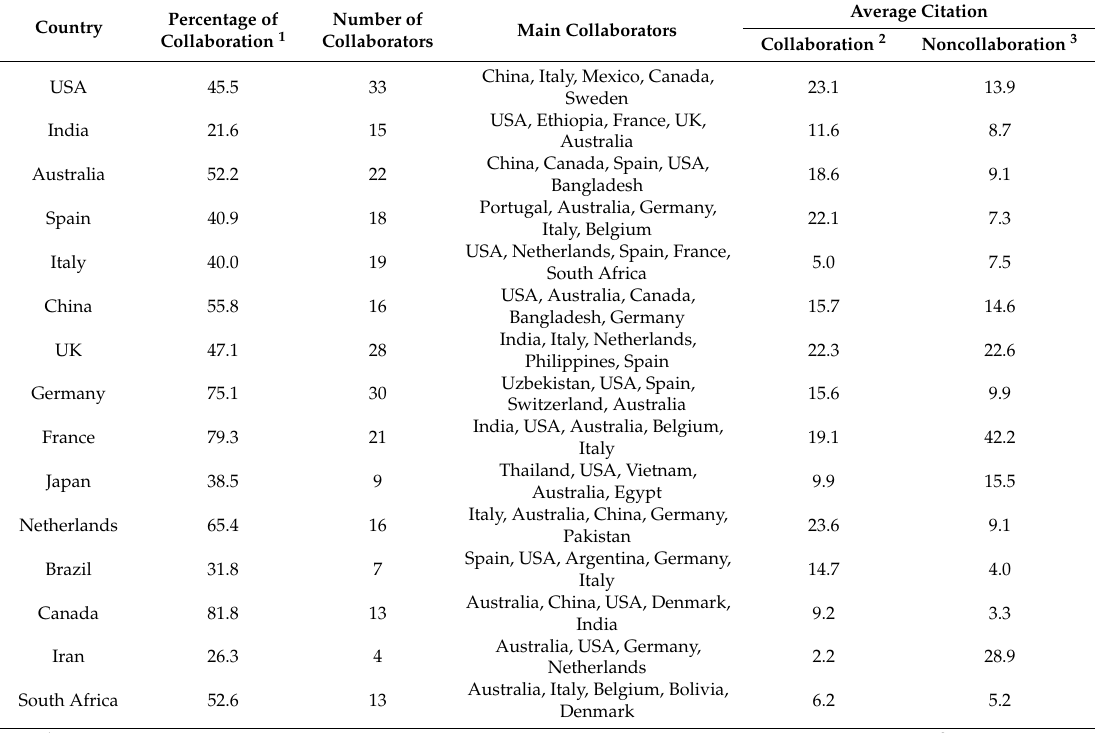
Table 4. International collaboration of the most active countries related to SI